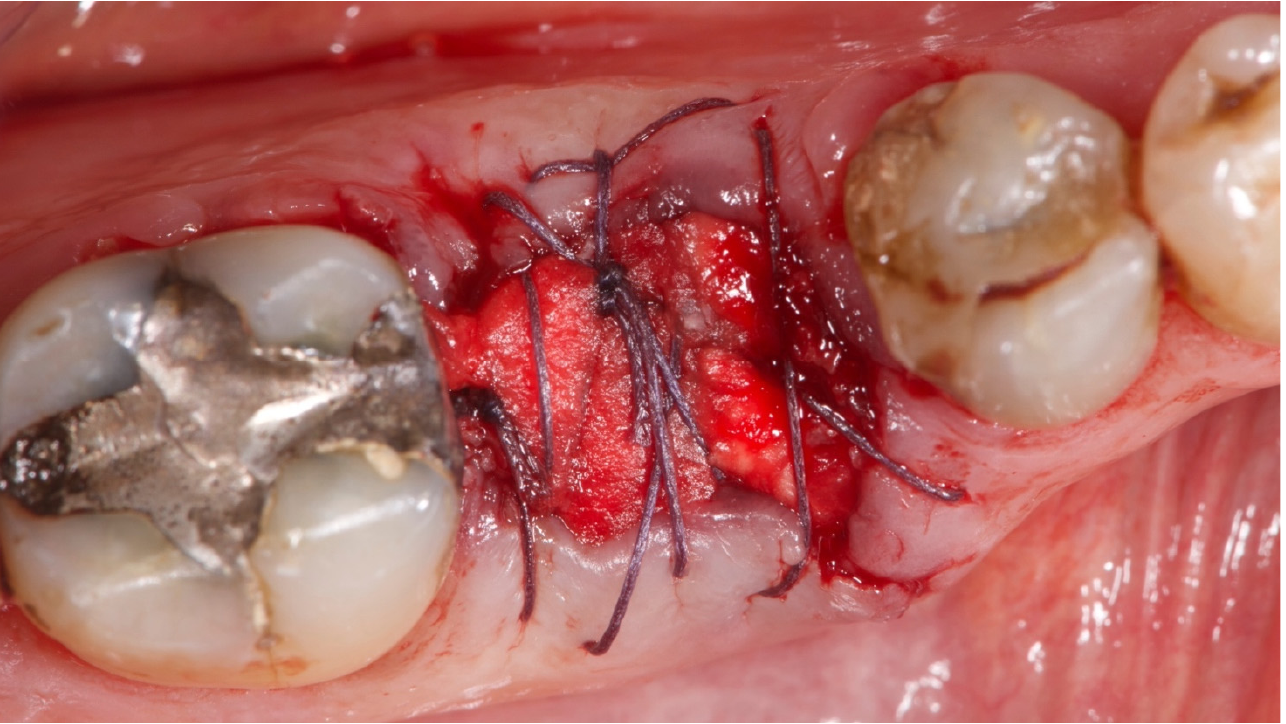
Figure 6. Residual socket sealed with collagen type one and resorbable suture.